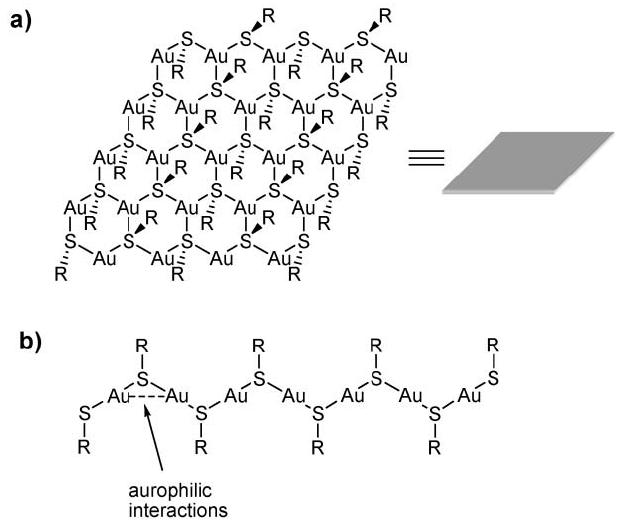
Figure 7. Primary structure of a gold(I) thiolate polymer ( 10 ). ( a ) Top view showing the two-dimensional arrangement; ( b ) Side view, showing that the Au atoms are placed very close to each other, stabilized by aurophilic interactions. Reproduced from ref. [44] with permission from The Royal Society of